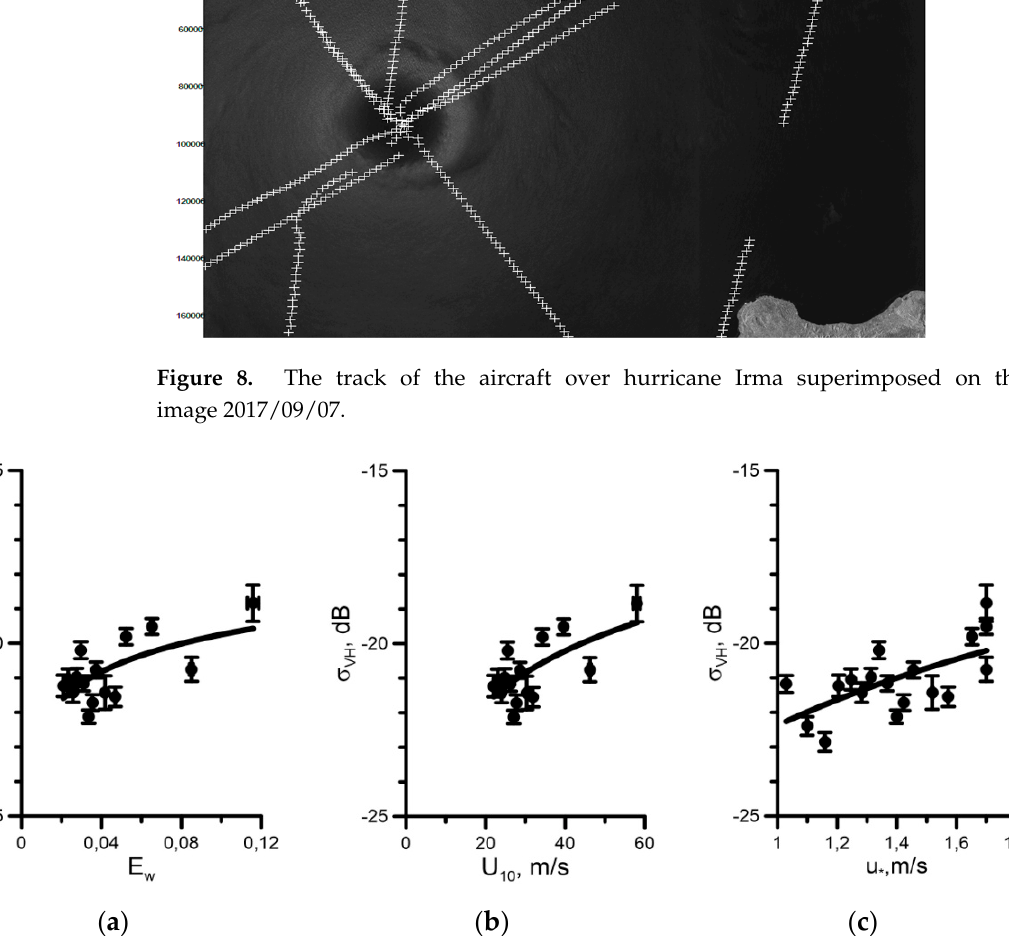
Figure 9. NRCS dependency on E w ( a ); U 10 ( b ); and u ∗ ( c ) for hurricanes Maria (2017/09/18–2017/09/27, Category 5 (SSHS)) and Irma (2017/09/03–2017/09/10), obtained using collocated satellite data and analysis of measurement results from SFMR and NOAA GPS-dropsondes. Solid lines—logarithmic approximation.